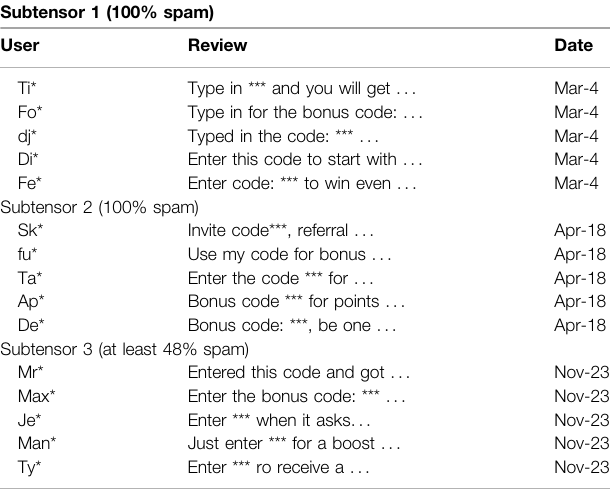
TABLE 5 | D-Cube successfully detects spam reviews in the SWM dataset. Subtensor 1 (100% spam)